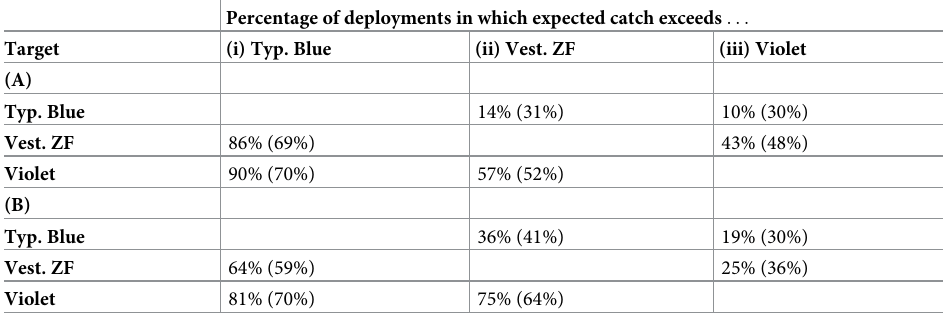
Table shows the percentage of 10,000 simulated catches in which the expected catch ( λ ) of the target in the row heading exceeded that in the column heading for the average catch replicate. Values in brackets indicate the same comparison of catch predictions, but incorporate the additional variability in tsetse catches across replicates estimated by the